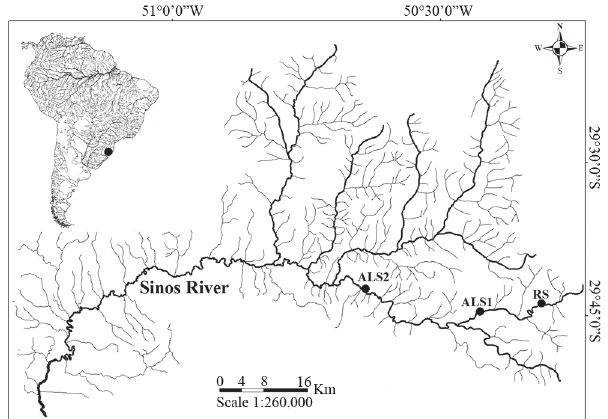
Fig. 1 . Sinos River basin. ALS=Automatic Listening Station, RS = Release